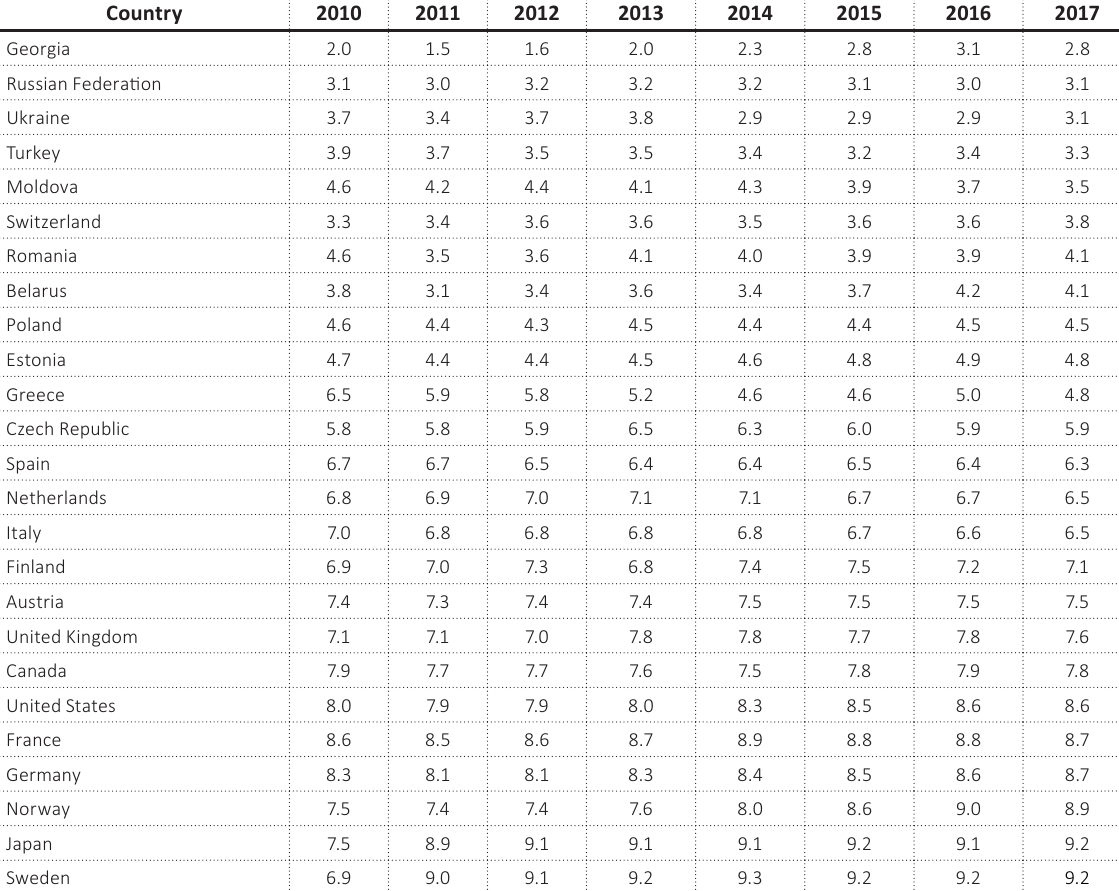
Table A3. General domestic government health expenditure (% of GDP) Country